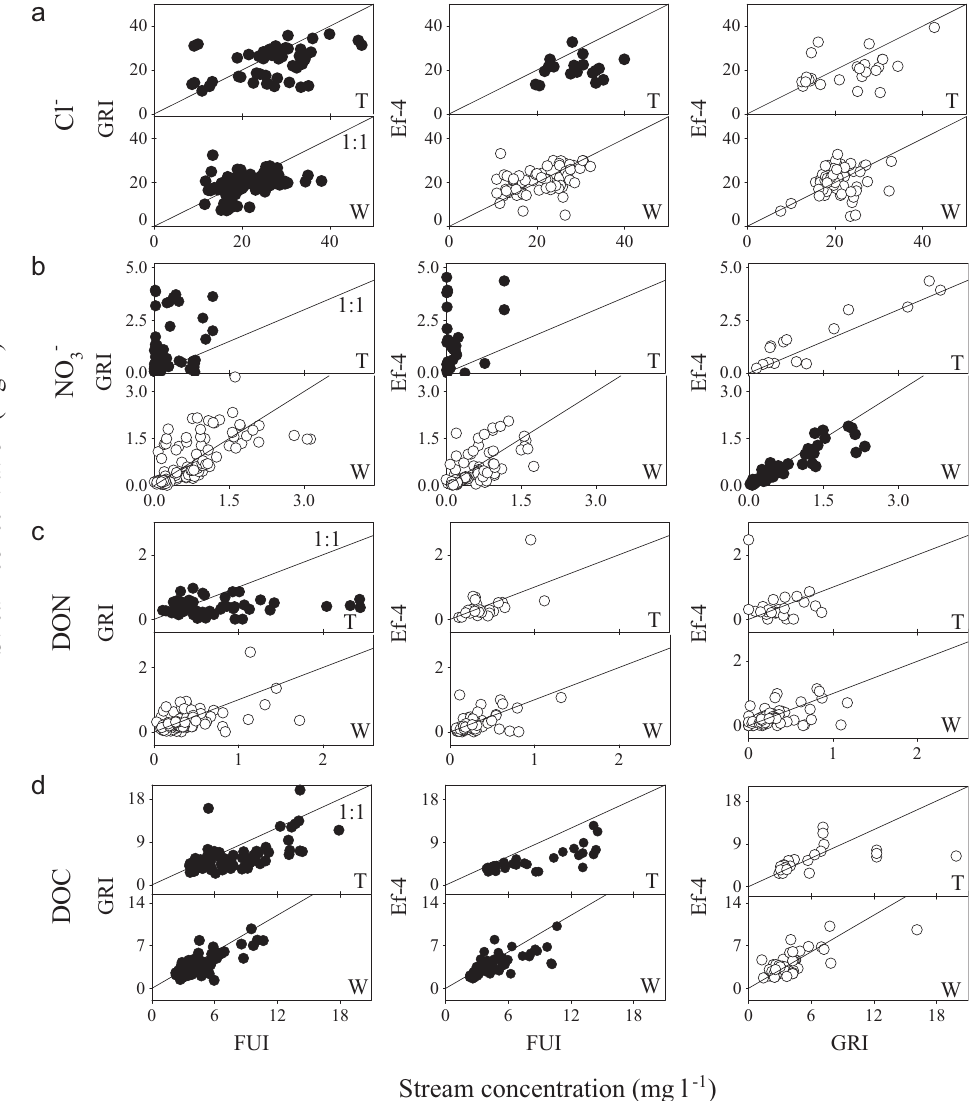
Fig. 4. Dispersion plots between instantaneous solute concentration for valley-bottom (FUI) and hillslope (GRI and Ef-4) stream water samples collected within the same day: (a) Cl − , (b) NO − , (c) DON, and (d) DOC. T: transition period; W: wet period. The 1:1 line is shown 3 in black. Circles are black only when differences between solute concentrations were statistically significant ( p < 0 .